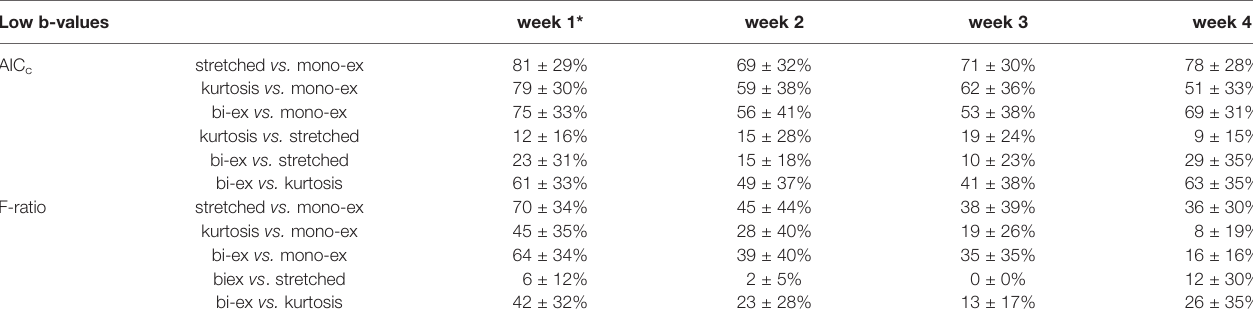
TABLE 1 | Mean ± standard deviation of median percentage values per mouse described better by the fi rst model of the comparison is shown in the table for DWI data obtained using low b-values. Low b-values week 1* week 2 week 3 AIC c stretched vs. mono-ex